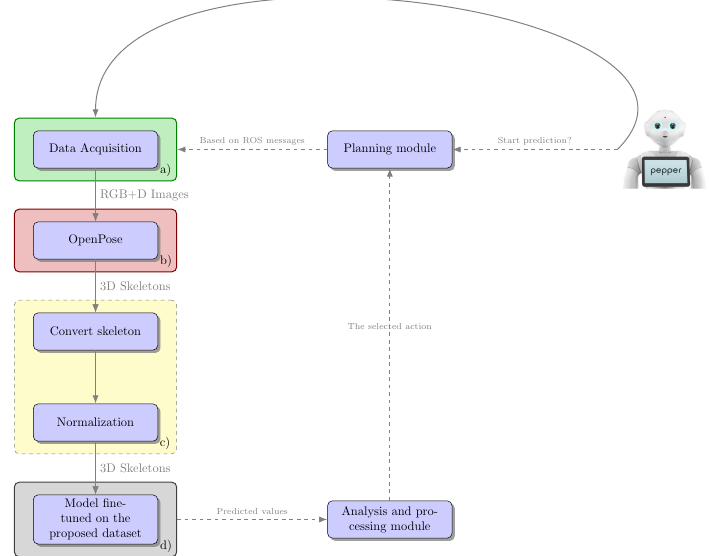
Figure 5. The architecture of the complete integration process of the human action recognition